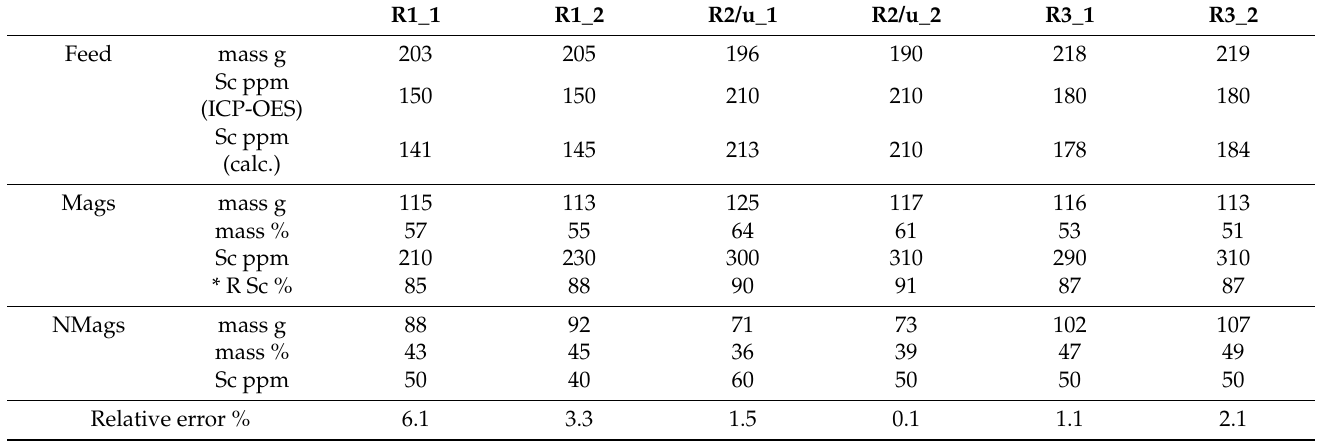
Table 4. Results of the second set of SLon rougher experiments for Kiviniemi composite samples from drill cores R1, R2/u and R3 processed with selected parameters (1 = 50 rpm and 0.5 T; 2 = 150 rpm and 1.0